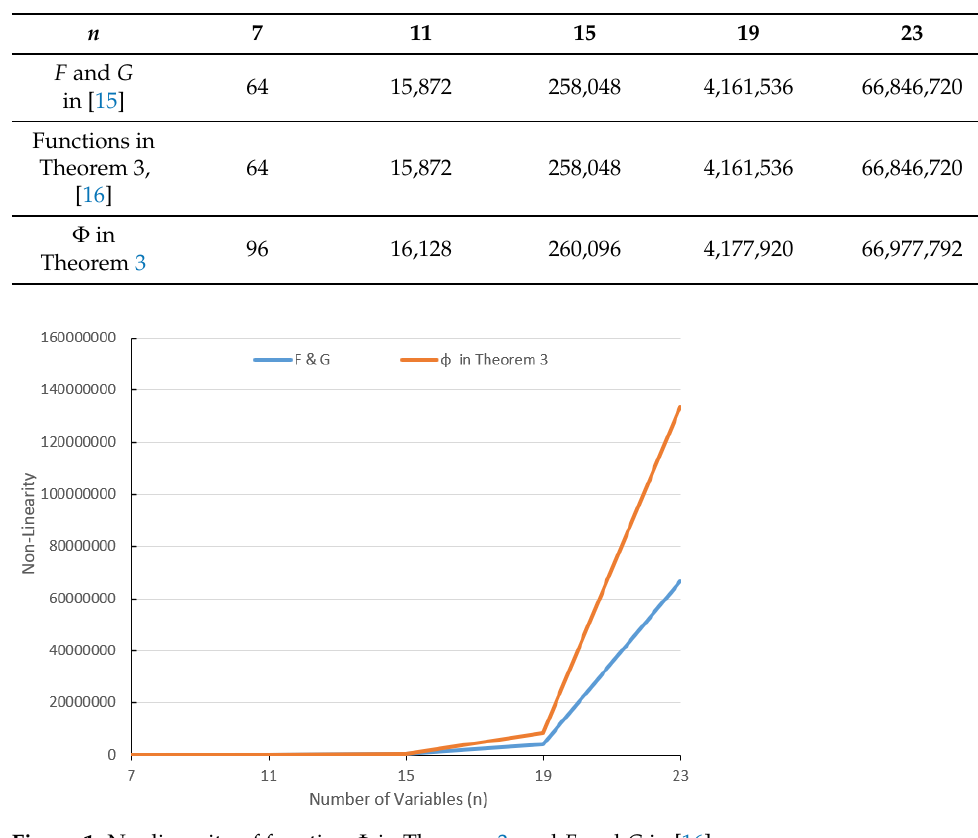
Table 1. Nonlinearity obtained in Theorems 2 and 3, and in [15,16] for n ≥ 7.